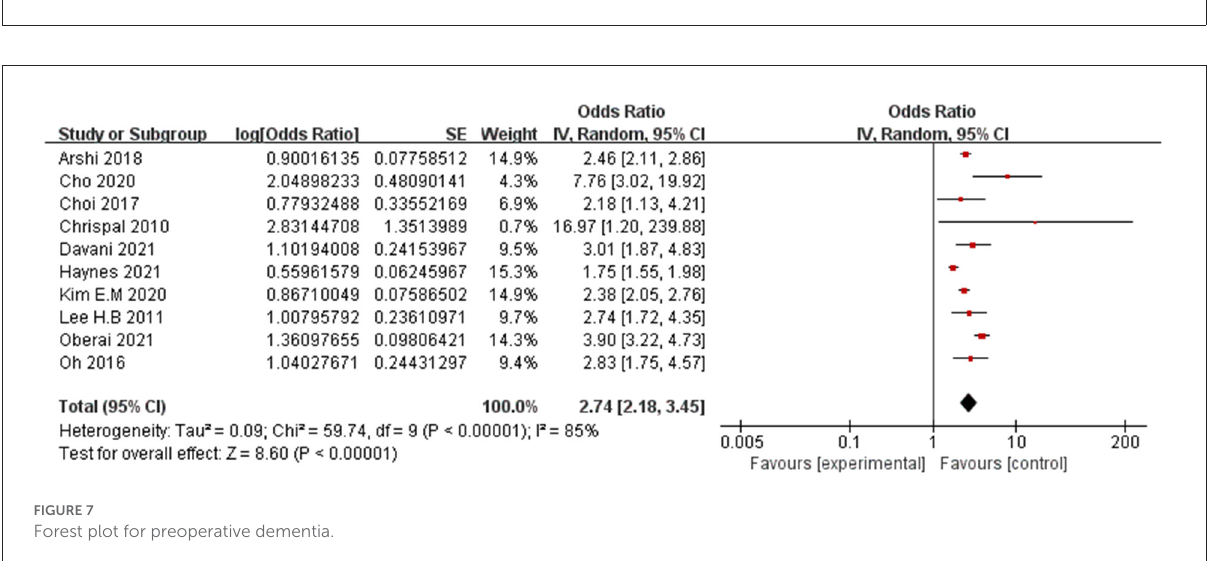
FIGURE7 Forest plot for preoperative dementia.